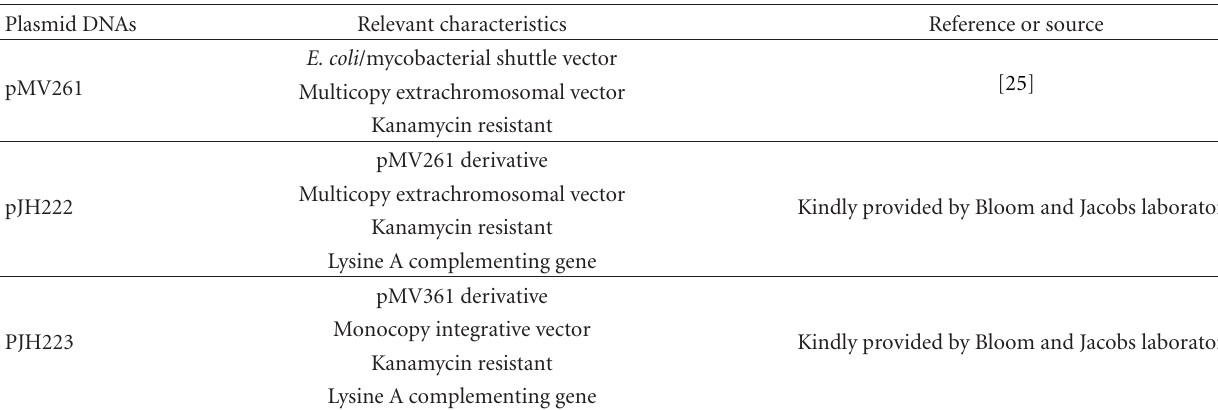
Table 2: List of parental E. coli /mycobacterial shuttle vectors used in this